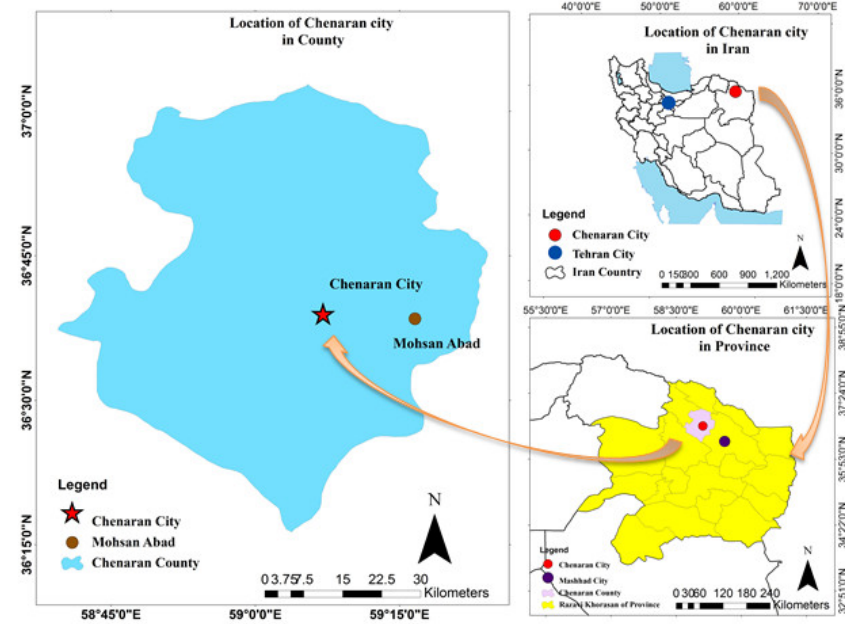
Fig. 2: Geographical location of Chenaran City in Fig.2: Geographical location of Chenaran City in Iran